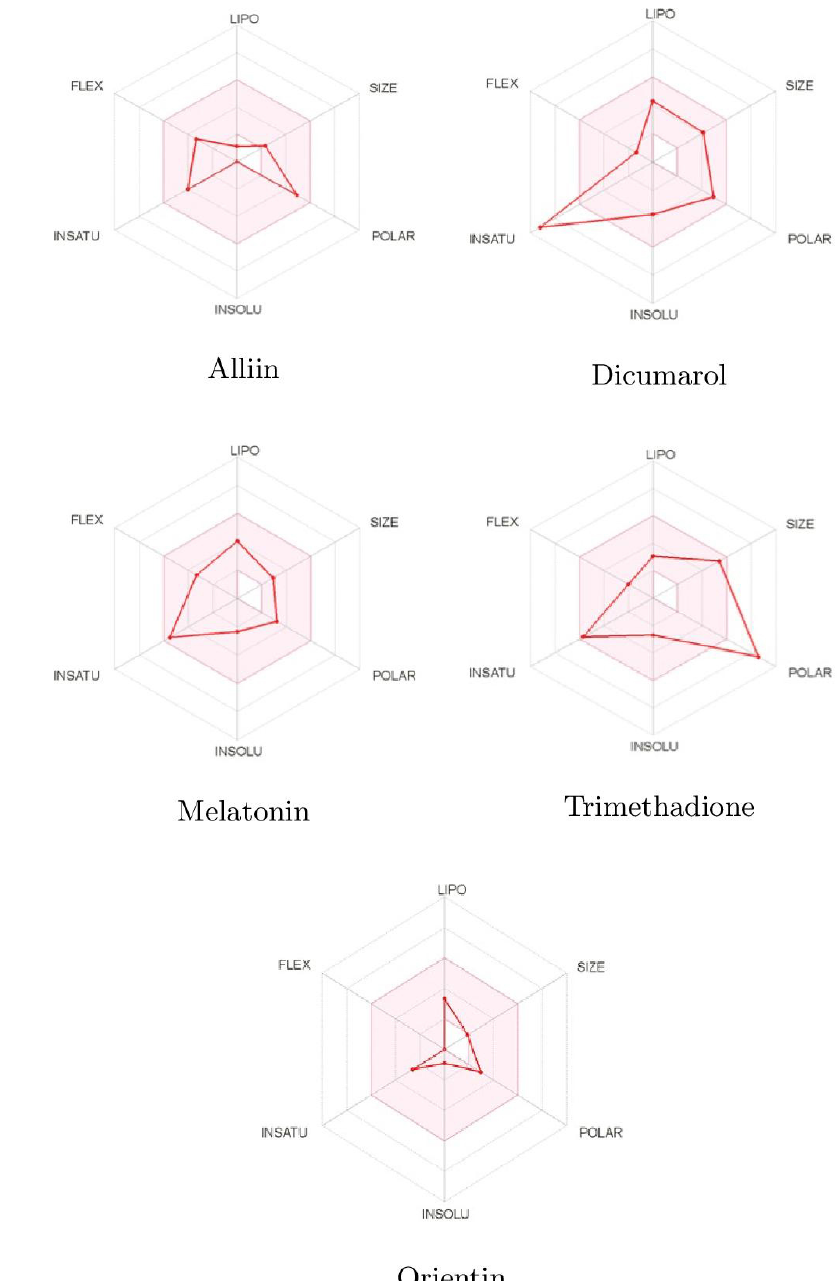
Figure 7. Bioavailabity radars of phytobioactives based on physicochemical indices with ideal values for oral